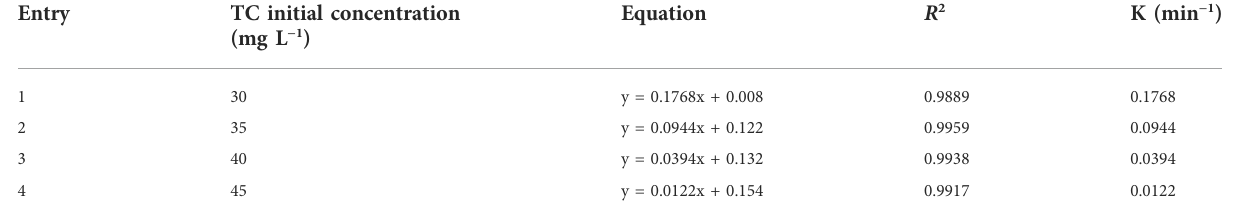
TABLE 1 The kinetic parameters for the pseudo- fi rst-order model of TC photocatalytic degradation at different concentrations. Entry